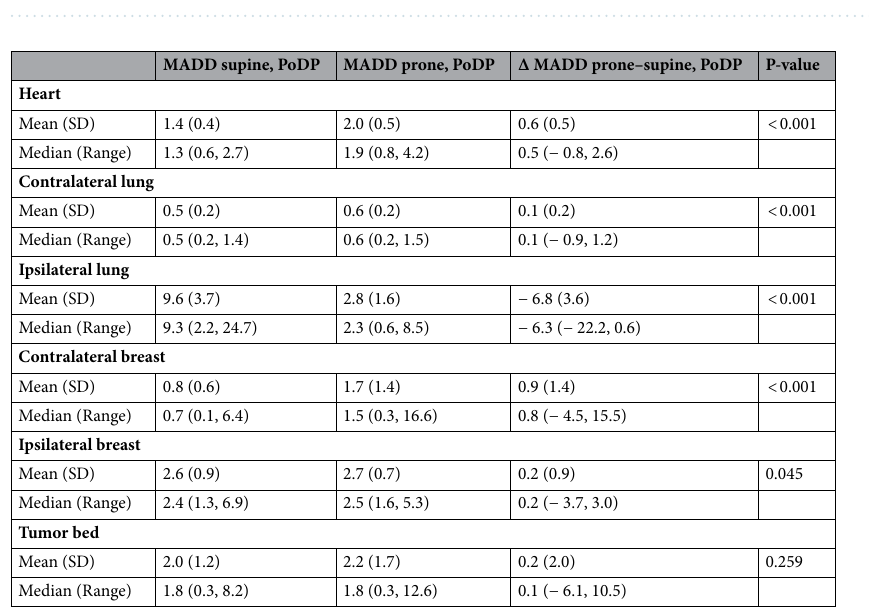
Figure 2. Mean absolute dose deviation (MADD) by structure and setup. MADD axis: square root scale. Box: lower quartile, median, upper quartile. Black dot: average of the MADDs. Color dots: outliers.